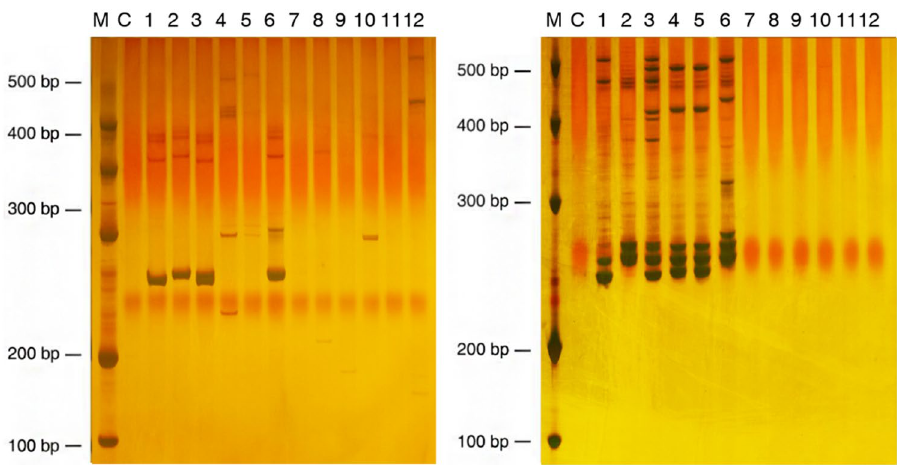
Figure 4. PCR-amplified products of markers McSSR_67 (left) and McSSR_78 (right) for six accessions of P. palustre and related species resolved on 7% PAGE. Lanes: M, 500 bp DNA marker; C, control; 1, P. palustre